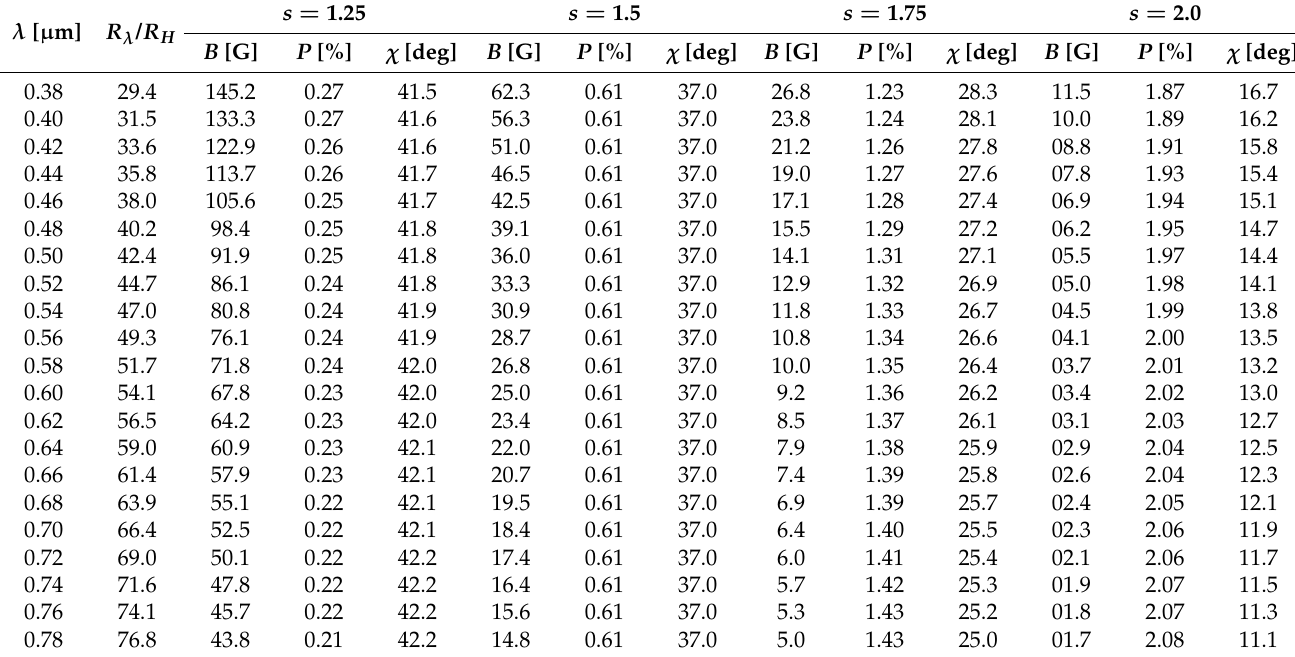
Table 1. Dependencies of radius R λ , magnetic field strength B , polarization degree P and position angle χ on wavelength λ for M BH / M (cid:12) = 10 8 , B H = 10 4 G, a ∗ = 0.9, ε = 0.155, l E = 0.2 and various values of s . s = λ [ µ m] R λ / R H